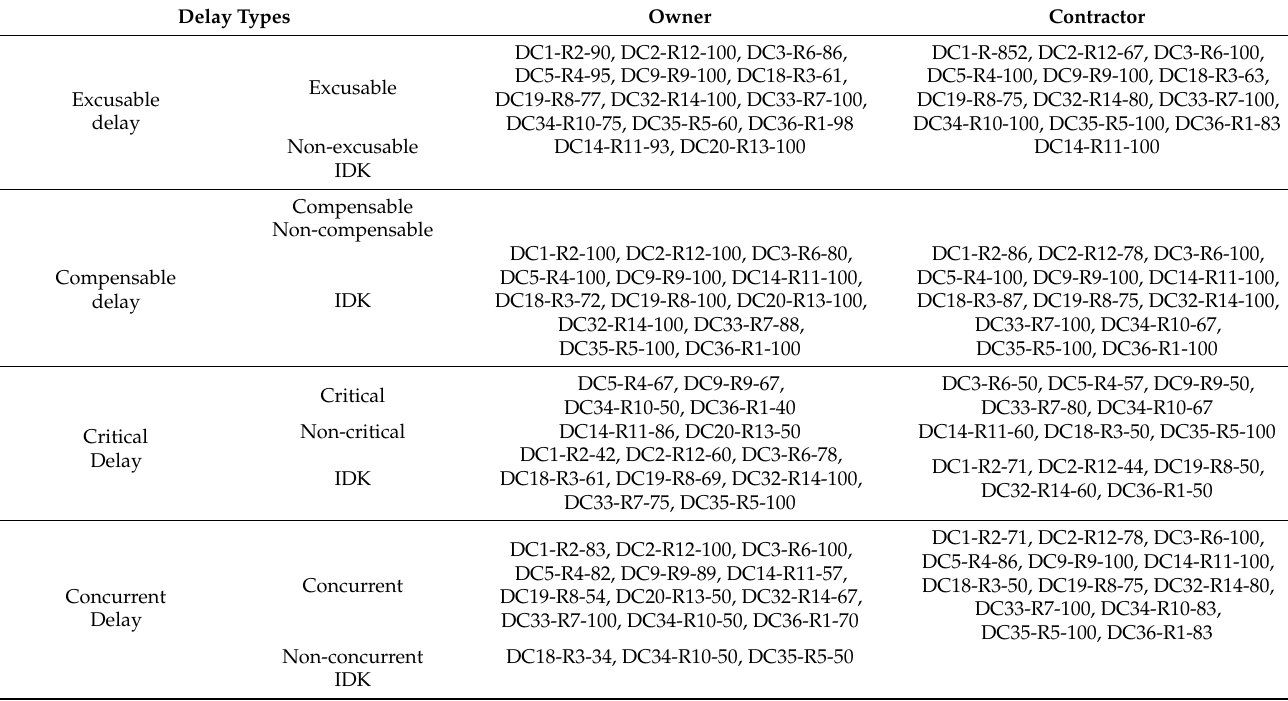
Table 5. Types of delay cause of owner and